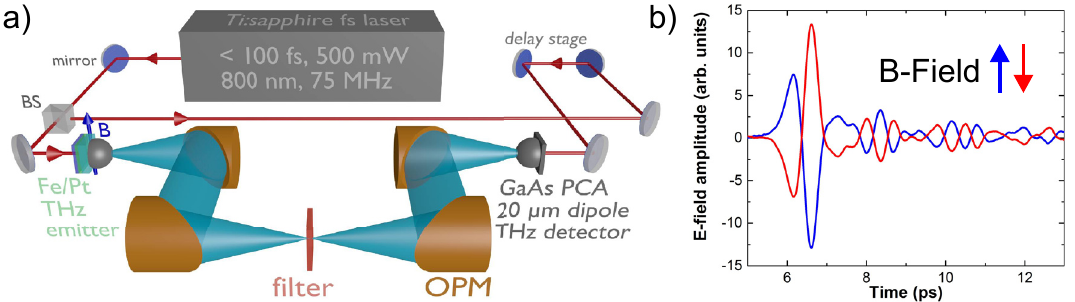
Figure2: a)Anexampleofaterahertztime-domainspectroscopy(THz-TDS)experimentalsetupmodifiedforspintronicemitters.b)THzpulses for two opposite directions of the magnetic